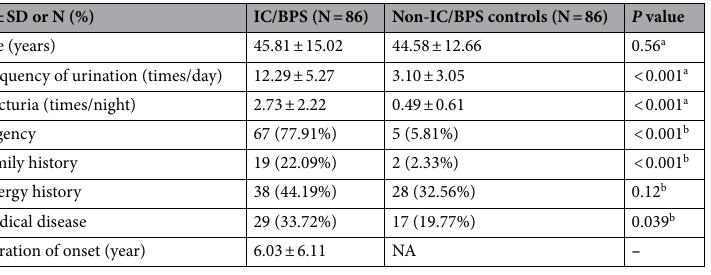
Table 1. Demographics, clinical symptoms, and medical history of patients with IC/BPS and non-IC/BPS controls. M mean, N number, SD standard deviation; medical diseases including hypertension, diabetes mellitus, asthma, rheumatoid arthritis, systemic lupus erythematosus, Sjogren’s syndrome, and various renal/ hepatic diseases. a t test, b Chi-square test.